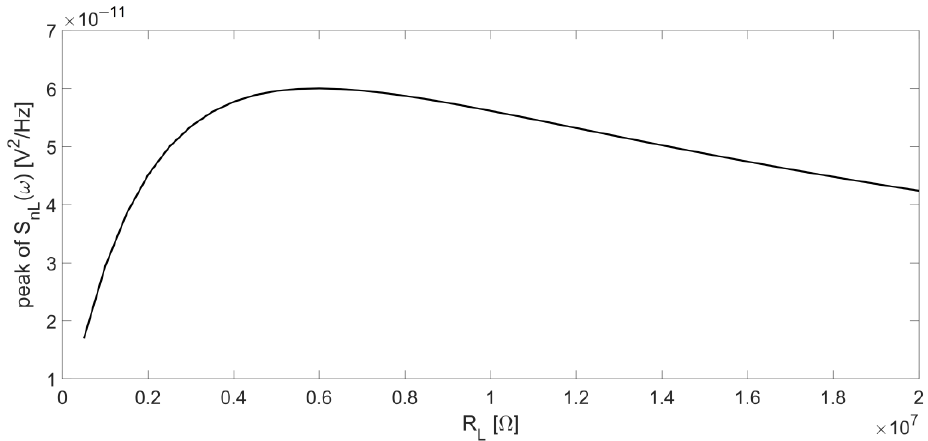
Figure 10. Peak of the output noise spectral density contribution due to R L as a function of R L itself. Using the set of parameters listed in Table 1, starting from low values of R L , this peak appears when R L ≅ 500 kΩ (dashed magenta and green curves in Figure 9), then increases up to R L ≅ 6 M Ω (Figure 10). Beyond this value, the peak decreases for increasing values of R L and the function S nL ( ω ) assumes lower values in the frequency range under inves- tigation.